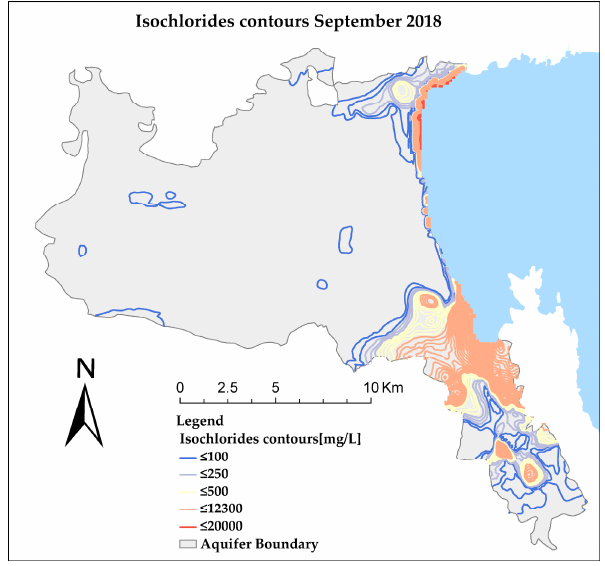
Figure 23. Isochlorides contours at the end of the simulation of seawater intrusion in September 2018.